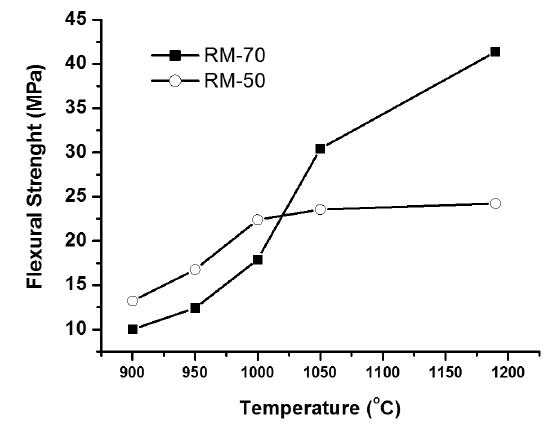
Figure 2. X-ray patterns of red mud and clay.